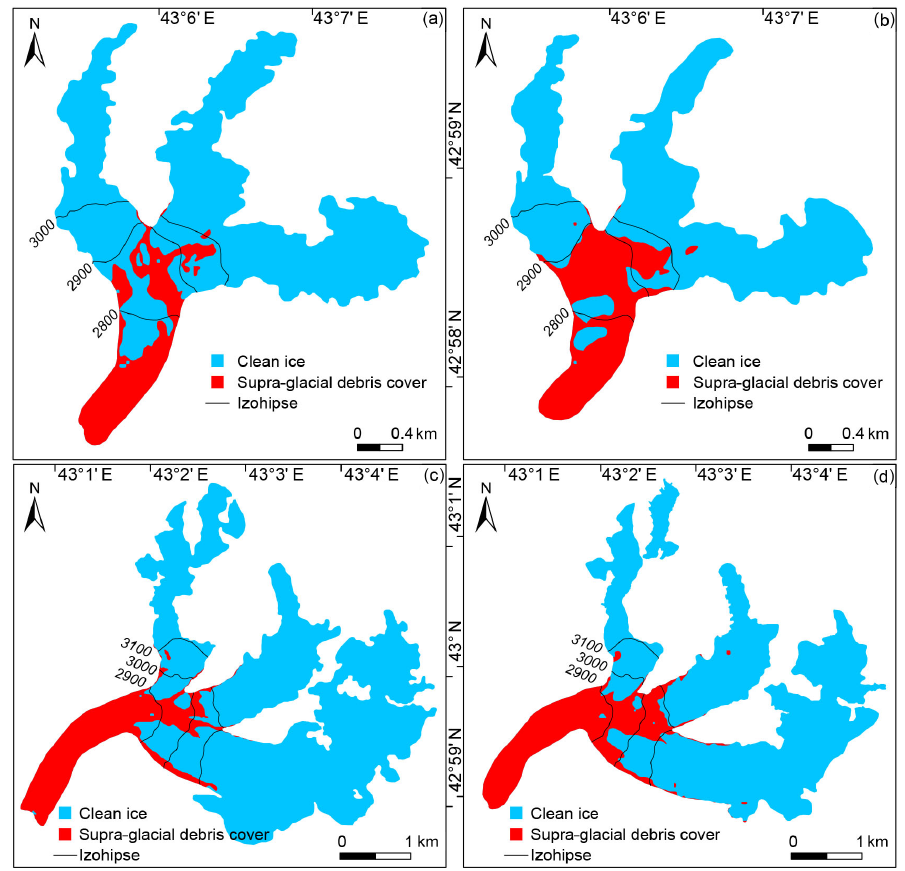
Figure 8. An example of the supra-glacial debris cover up-glacier migration onto Shkhara Glacier in (a) 1986 and (b) 2014 and onto Khalde Glacier in (c) 1986 and (d)